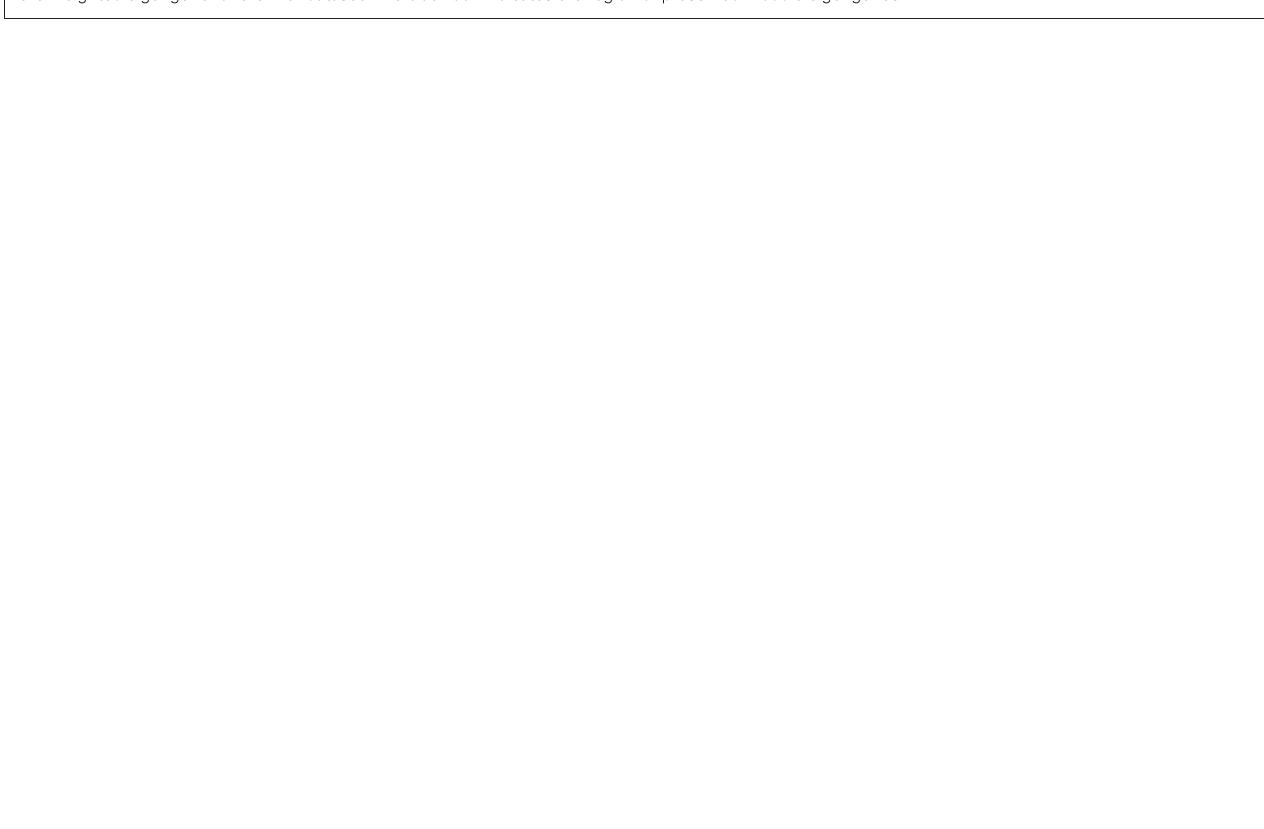
FIGURE A1 | MICA shows strong preservation of eigengenesin the liver dataset. Eigengene correlations at 5% cutoffs from 10% to 90% MM and also the weighted eigengene for the liver dataset. The black box indicates the region of preserved module